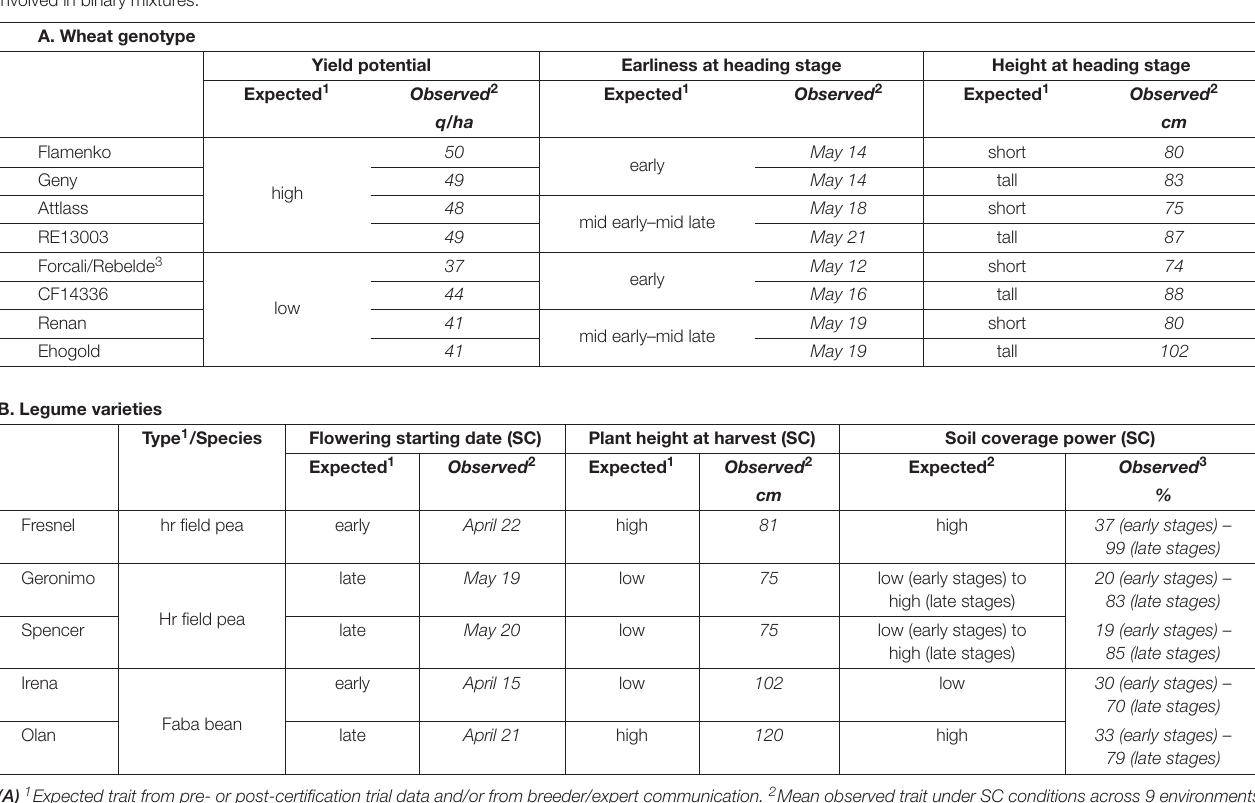
TABLE 1 | Phenological, architectural, and agronomic traits in sole crop (SC) of (A) the 8 winter bread wheat genotypes and (B) the 5 field pea and faba bean varieties involved in binary